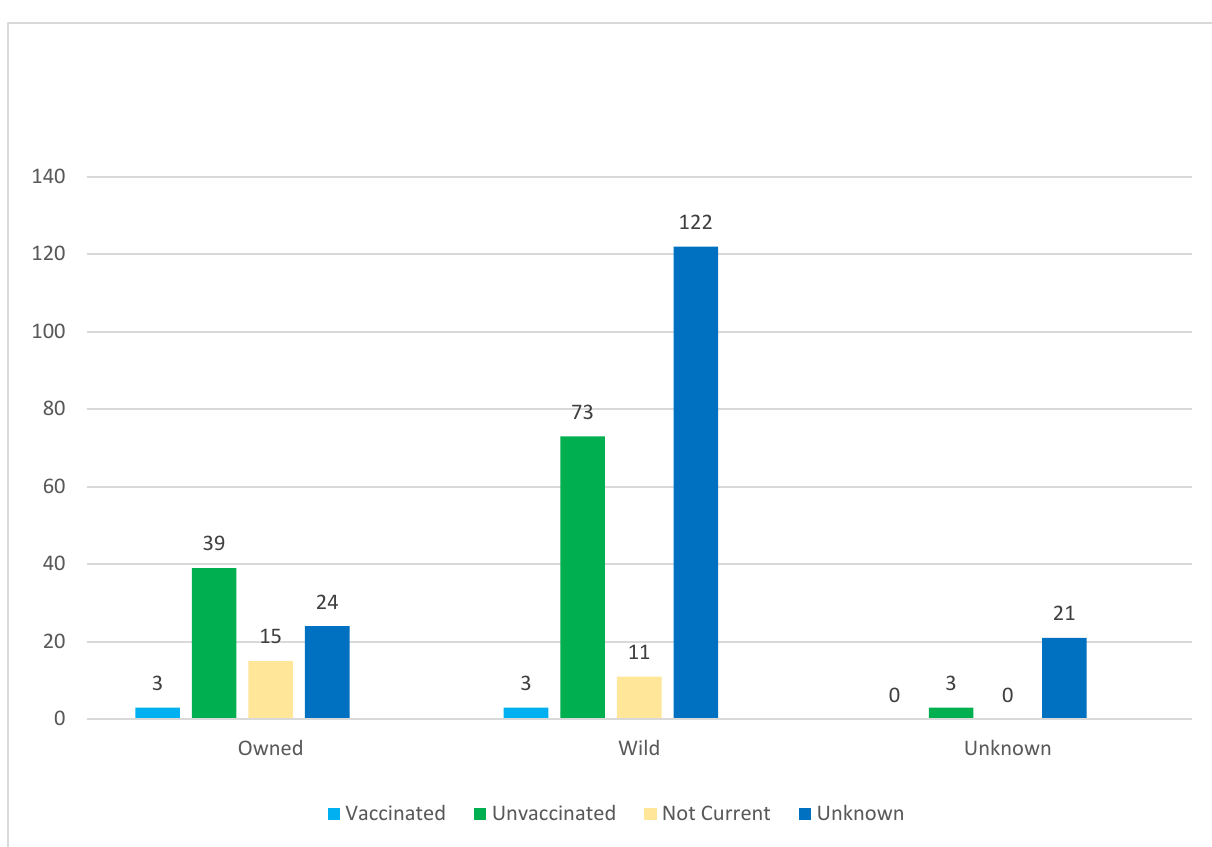
Figure 2. Ownership and vaccination status of rabies-positive cats submitted to the NYSDOH Rabies Laboratory.